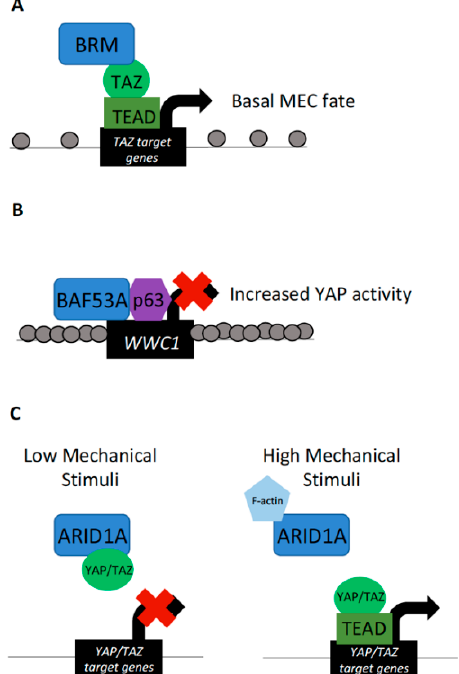
Figure 2. YAP / TAZ interactions with the SWI / SNF complex. ( A ) BRM interaction with TAZ–TEAD at TAZ target loci drives transcription of genes specifying a basal cell fate in mammary epithelial cells (MECs). ( B ) The SWI / SNF subunit Brahma-associated factor 53a ( BAF53A ) interacts with p63 to inhibit the expression of WWC1 / KIBRA . This results in the overactivation of YAP and is a hallmark of head and neck squamous cell carcinoma (HNSCC). ( C ) Direct interaction of the SWI / SNF subunit ARID1A with YAP / TAZ under conditions of low mechanical stimuli sequester YAP / TAZ from activating target gene expression. Under conditions of high mechanical stimuli, ARID1A itself is sequestered by nuclear F-actin, allowing YAP / TAZ to bind TEAD at target loci and induce transcription. Of note, interactions of YAP / TAZ with ARID1A does not alter chromatin accessibility at YAP / TAZ target loci. Spacing of grey dots, representing nucleosomes, represents chromatin